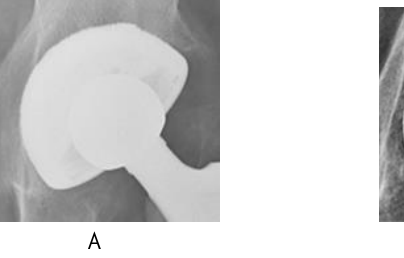
Figure 2 : Cup osseointegration A : good B: Ssatisfactory C:Unsatisfactory